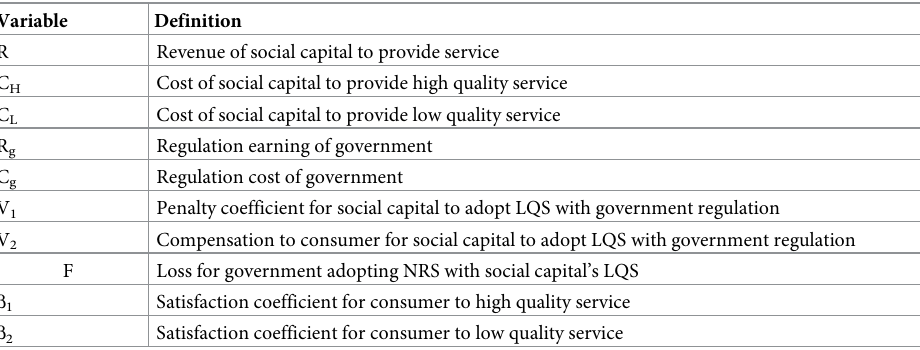
Table 1. Major variable and definition.